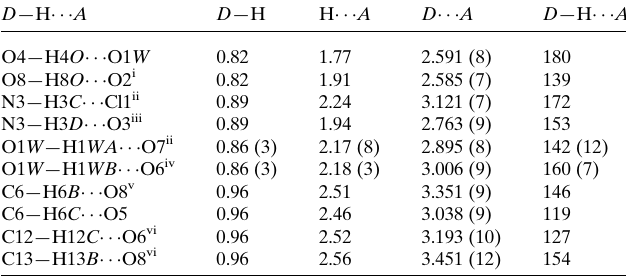
Table 1 Hydrogen-bond geometry (A˚ , (cid:4) ).